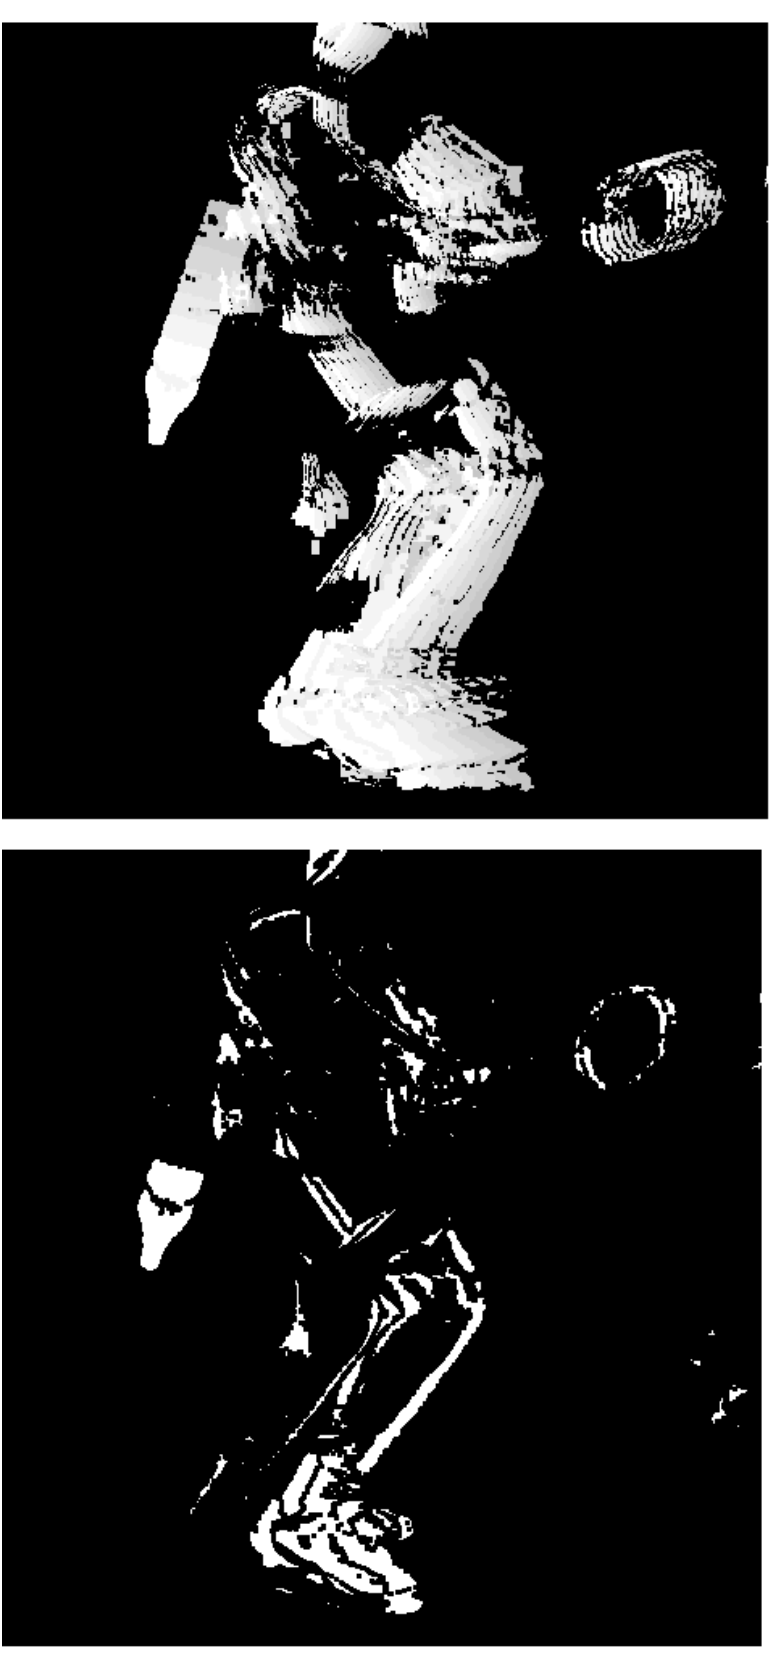
Figure 8. Shuttlecock moving along a player: top = original image, middle = accumulated diff, and bottom = differential